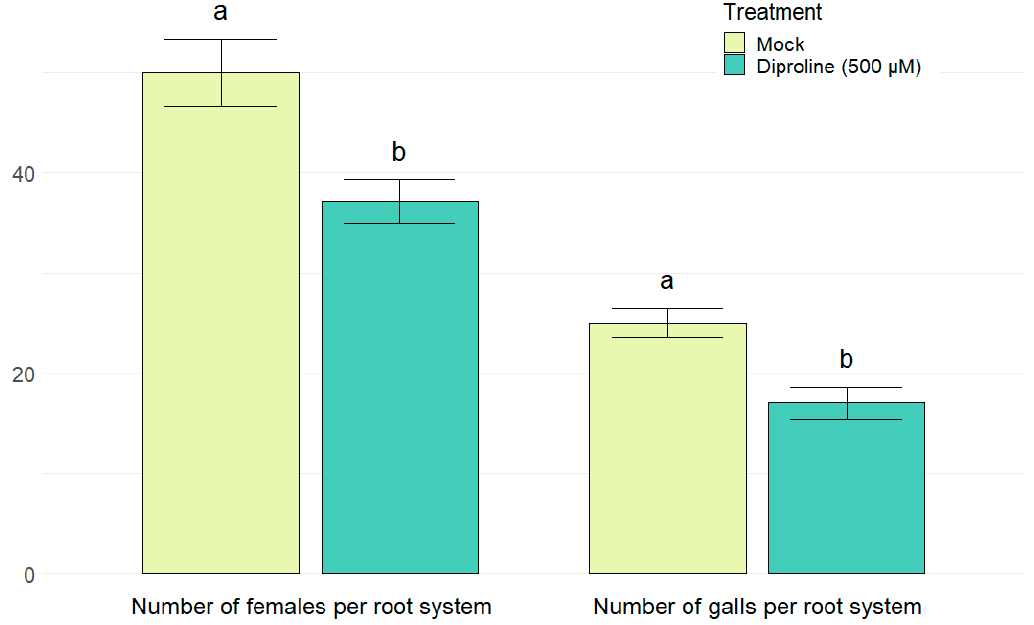
Figure 3. Number of females and galls in root systems of rice plants, 14 days after inoculation with 250 Meloidogyne graminicola second stage juveniles per plant. One day before inoculation, fourteen-days-old rice plants were treated with water (mock) or 500 µM diproline. The bars show the average of 24 plants per treatment, analyzed over three replications. To cancel out batch effects, data from the replicate experiments were combined and normalized. Error bars indicate standard errors, while letters represent statistical differences in comparison with the mock treated plants.